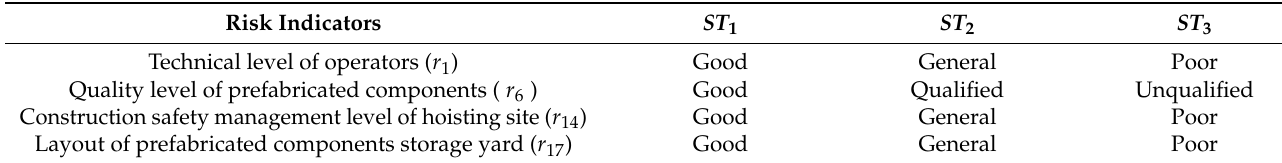
Table 3. Three-state discrete variable risk state division.